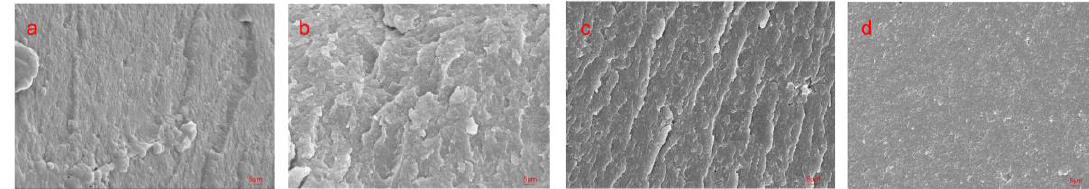
Figure 9. Fracture surface micrographs of the cured adhesive samples: ( a ) SPI-CA adhesive, ( b ) SPI-Urea-CA adhesive, ( c ) SPI-SDS-CA adhesive, ( d ) SPI-SHS-CA adhesive. Figure 8. ATR-FTIR spectroscopic of the cured adhesive samples: ( a ) SPI adhesive, ( b ) SPI - CA adhesive, ( c ) SPI-Urea (U) adhesive, ( d ) SPI-Urea-CA adhesive, ( e ) SPI-SDS adhesive, ( f ) SPI-SDS-CA adhesive, ( g ) SPI-SHS-CA adhesive, and ( h ) SPI-SHS-CA adhesive.